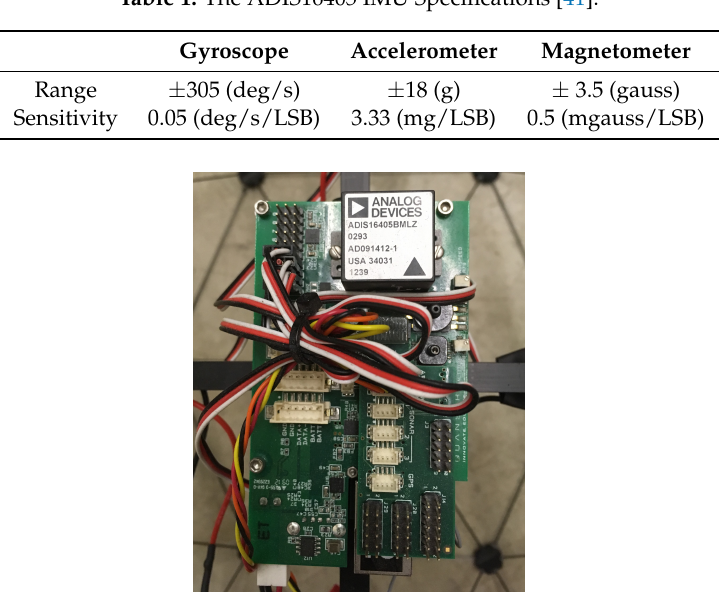
Figure 2. The ADIS16405 IMU module on the Qball-X4 quadrotor